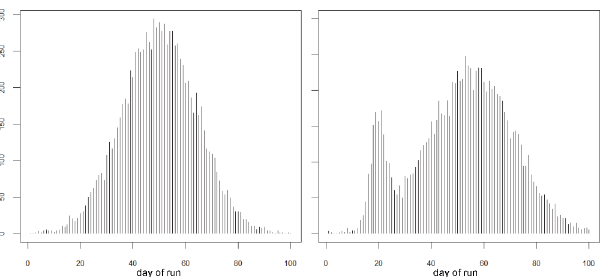
Fig 1. Two simulated run distribution patterns modeled using a population size of 10,000 smolts and run duration of 100 days. Simulations are based on patterns observed in nine years of smolt trapping data (1999 – 2007) from seven ODFW Life Cycle Monitoring sites on the Oregon